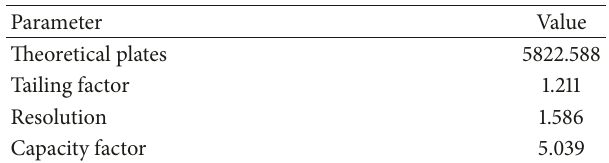
Table 5: System suitability